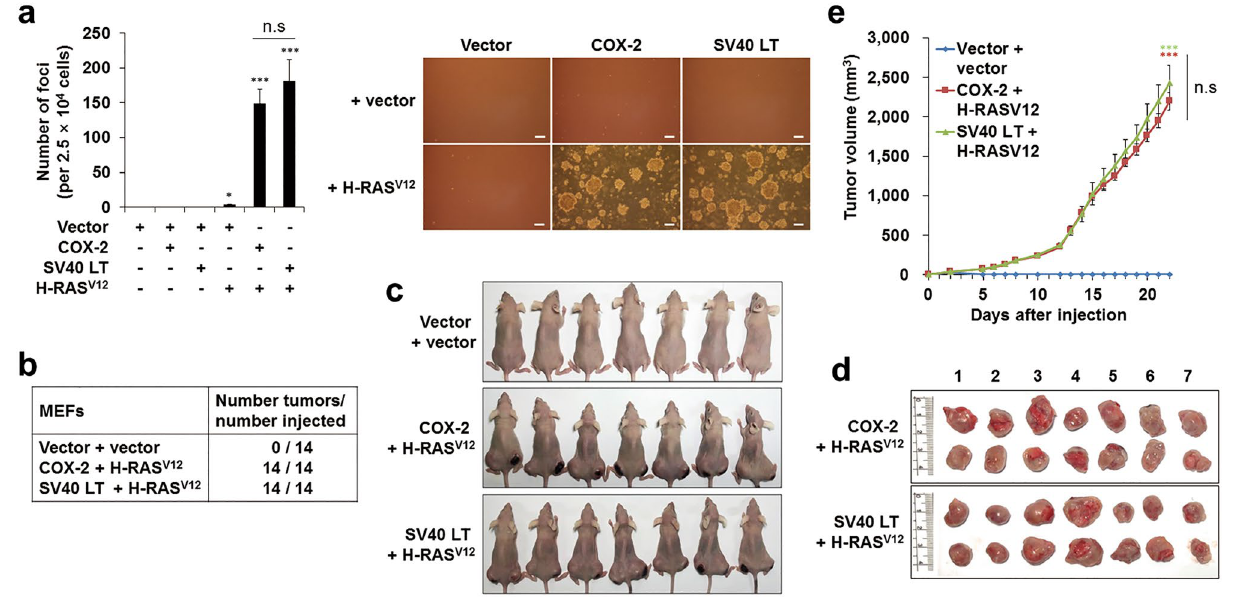
Figure 3. COX-2 overexpression induces neoplastic transformation under oncogenic RAS activation in MEFs. ( a ) Soft agar assay. MEFs were infected with retroviruses as indicated. 2.5 × 10 4 cells were seeded on the soft agar and the number of foci was counted (left). Representative data were shown (right). Data are means ± SE ( n = 8; * P < 0.05, *** P < 0.001 vs. Vector; n.s, not significant). Scale bars = 100 μm. ( b – e ) In vivo tumor formation assay. MEFs were infected with retroviruses and injected into nude mice. The total number of tumors per group ( b ), mice ( c ), resected tumors ( d ) and tumor volumes ( e ) were shown. Data are means ± SE ( n = 14; *** P < 0.001 vs. Vector + vector; n.s, not significant at the final